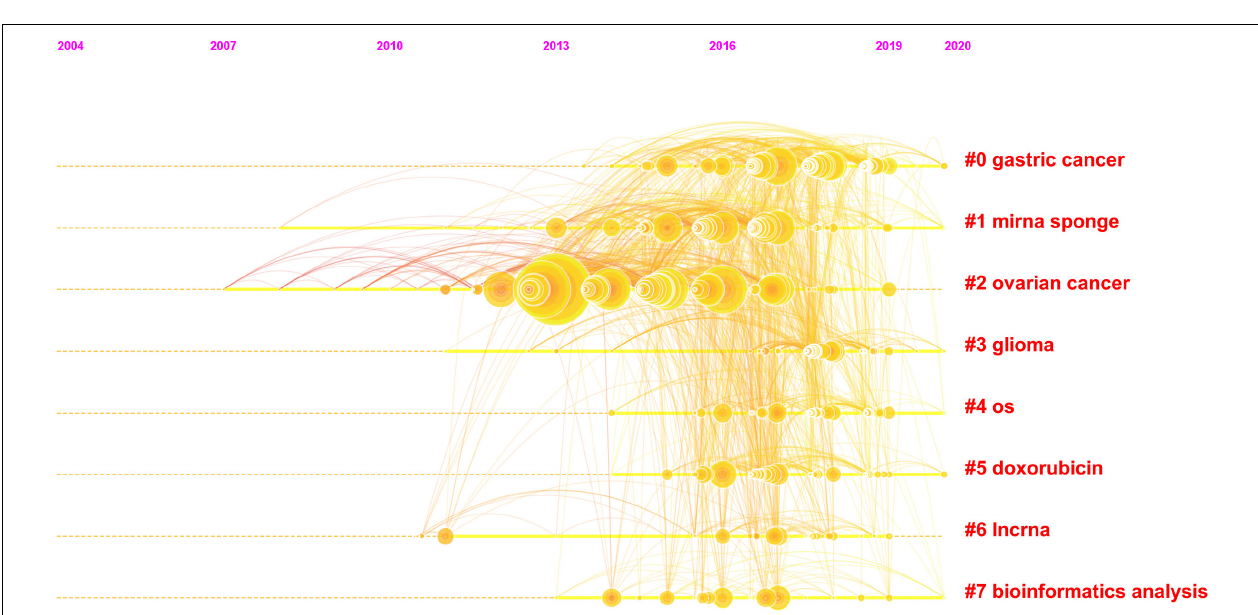
FIGURE 6 | The analysis of references. Co-citation map (timeline view) of references from publications on the crosstalk between microRNAs and circular RNAs.